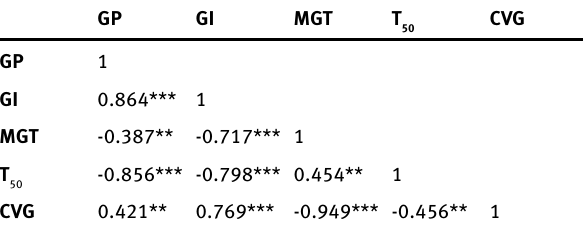
Table 5: Pearson correlation coefficients between germination para- meters in common bean genotypes at 2 weeks GI